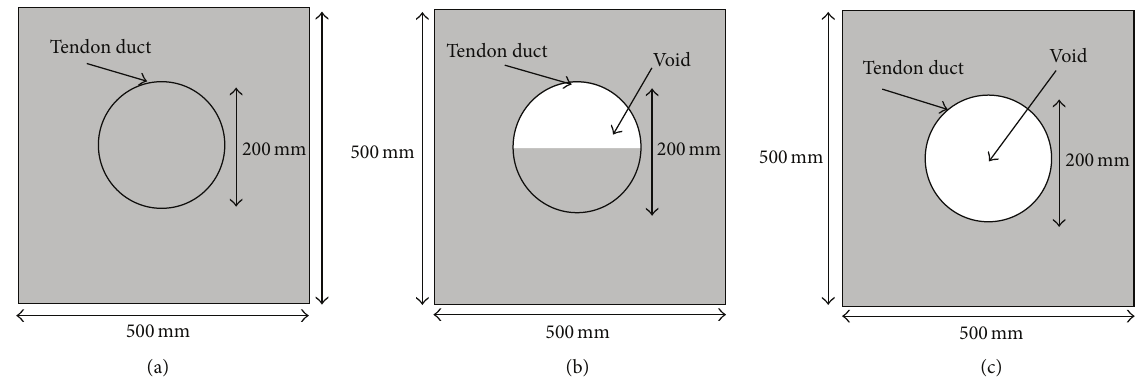
Figure 2: Schematic diagrams of simulation models showing filling of duct at (a) 100%, (b) 50%, and (c) 0%.